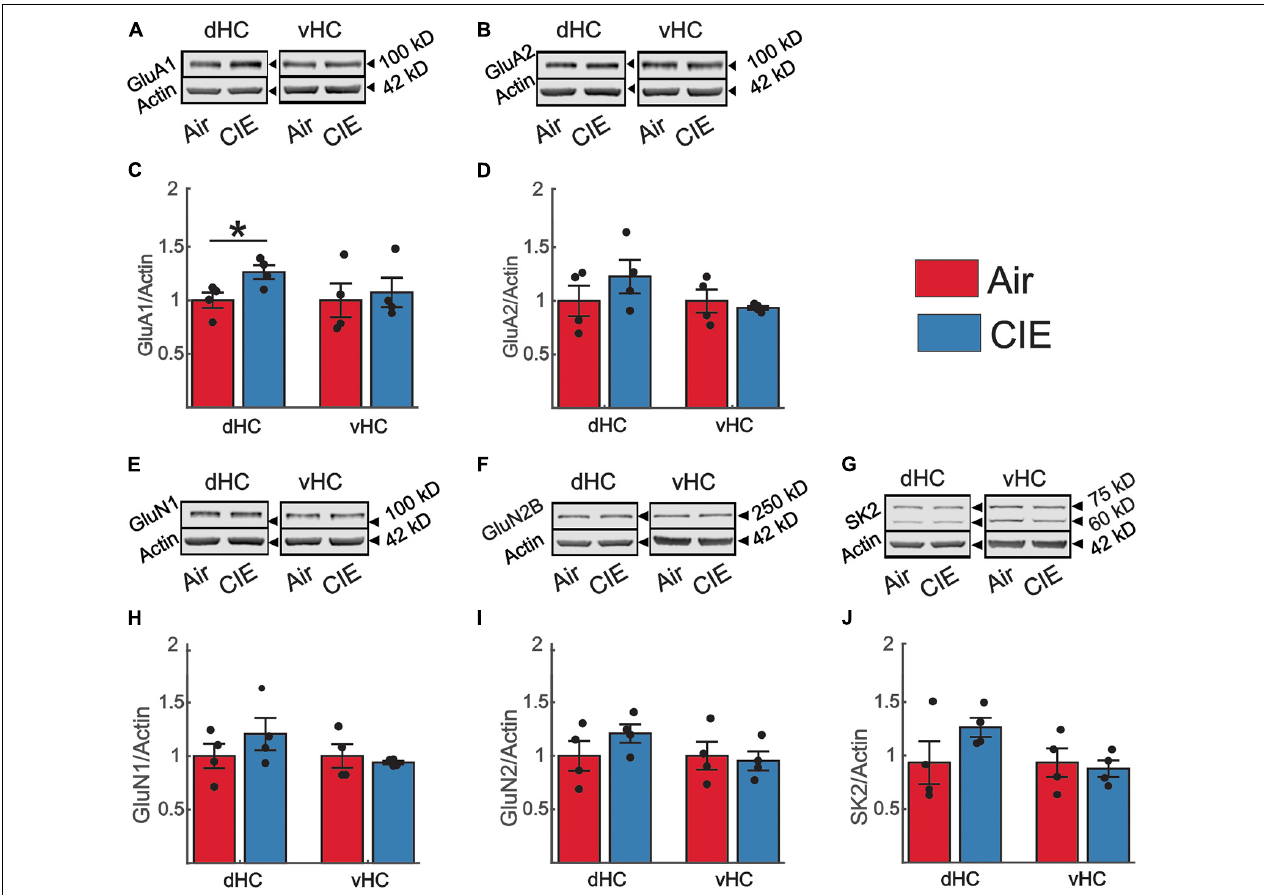
FIGURE 7 | CIE does not impact the expression levels of proteins commonly associated with alterations in excitatory neurotransmission in the vHC. However, in the dHC, the GluA1 subunit is upregulated. Representative western blot examples illustrating the expression of (A) the GluA1 and (B) GluA2 subunit of the AMPA receptor, (E) the GluN1, (F) and GluN2 subunit of the NMDA receptor and (G) SK2. In panels (A,B,E–G) the corresponding expression of actin (normalization protein) is shown in the lower blot panel of each protein of interest. (C,D,H–J) Group data, normalized to actin and the internal control group (Air), for the (C) GluA1 (Air n = 4, CIE n = 4), (D) GluA2 (Air n = 4, CIE n = 4), (H) GluN1 (Air n = 4, CIE n = 4), (I) GluN2B subunit (Air n = 4, CIE n = 4) and (J) the SK2 channel (Air n = 4, CIE n = 4) illustrating an increase in the expression of the GluA1 subunit (Air n = 4, CIE n = 4) in the dHC without changes in other proteins in the dHC and vHC of Air and CIE-treated rats. All data are expressed as the mean ± SEM, * p <